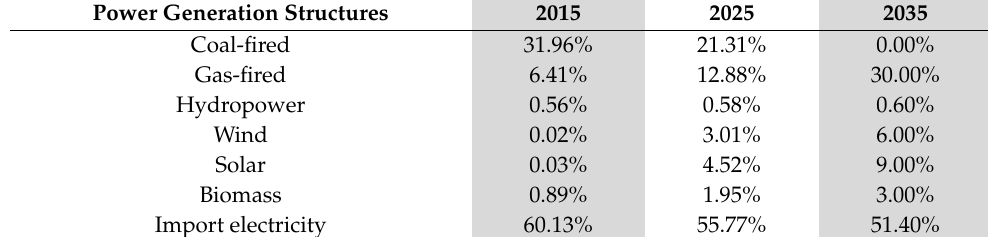
Table 3. The energy structure of the power generation